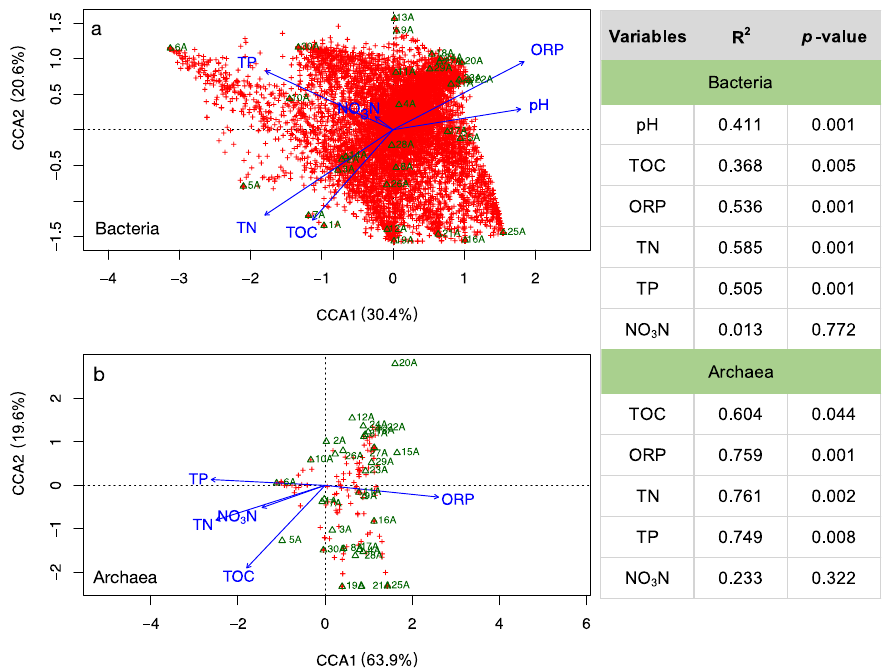
Figure 6. Canonical correspondence analysis of microbial community (bacteria ( a ) and archaea ( b )) and environmental variables in sediment. The red cross represents OTUs, while green triangle represents sampling sites.